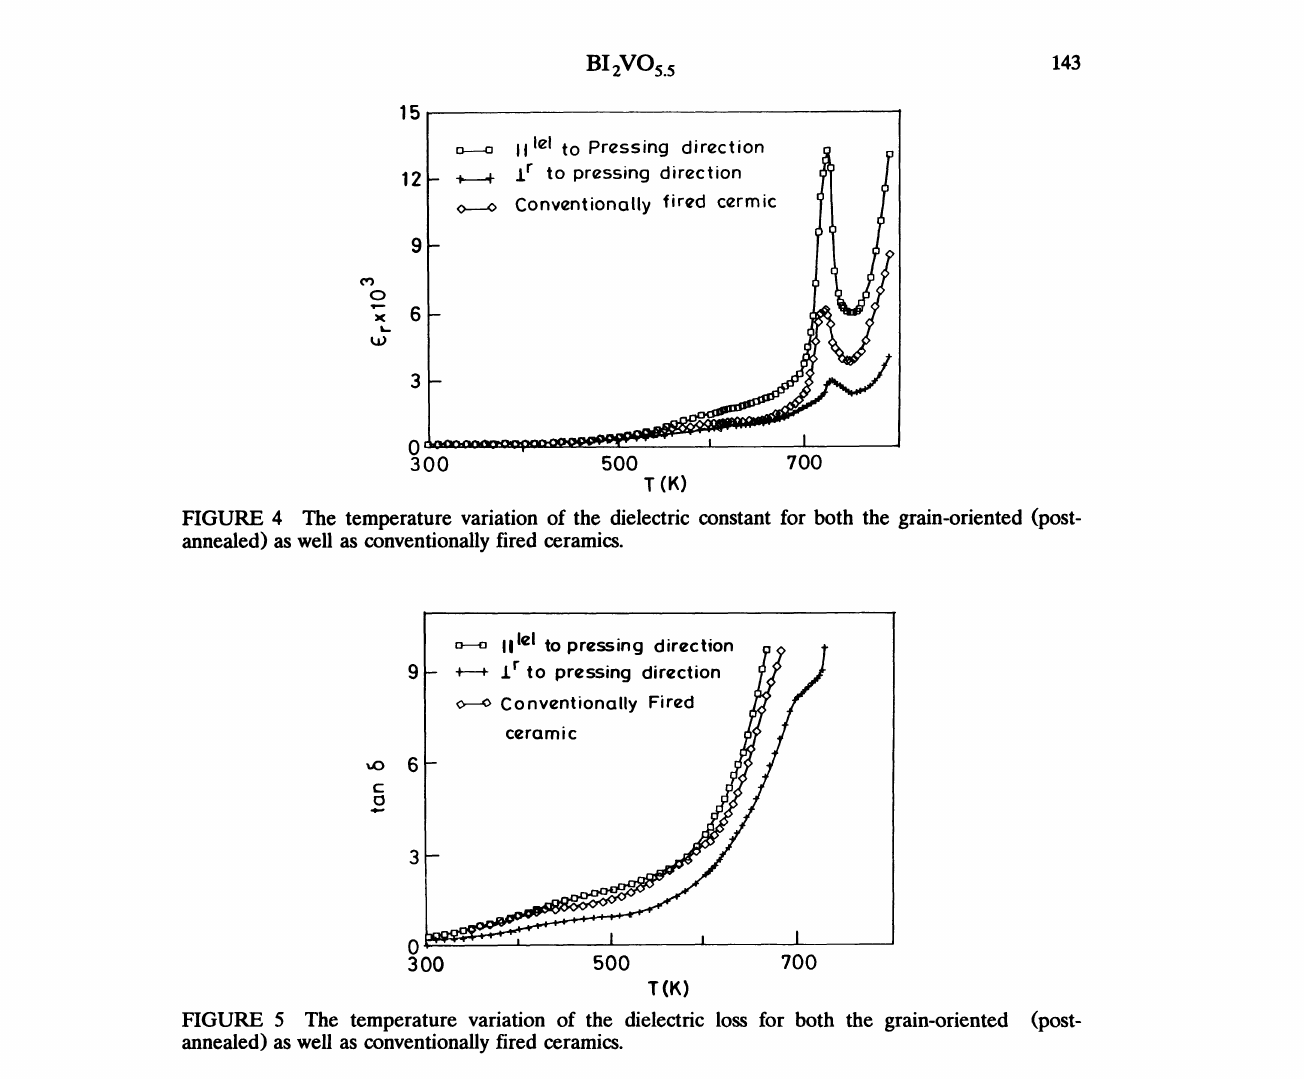
FIGURE 5 The temperature variation of the dielectric loss for both the grain-oriented annealed) as well as conventionally fired ceramics. variation of the loss tangent (tan 8) for post-annealed and conventionally fired ceramics is shown in Fig. 5. The loss tangent increases with increase in tempera- ture and rises sharply above 600 K in both the cases. The as-quenched, post-an- nealed, and conventionally fired ceramics exhibit ferroclectric hysteresis loops at 300 K. The remnant polarisation (P r) and coercive field (E c) obtained from the hysteresis loop studies arc given in the Table 1. The P, for post-annealed ceramics is higher than that of as-quenched and covcntionally fired